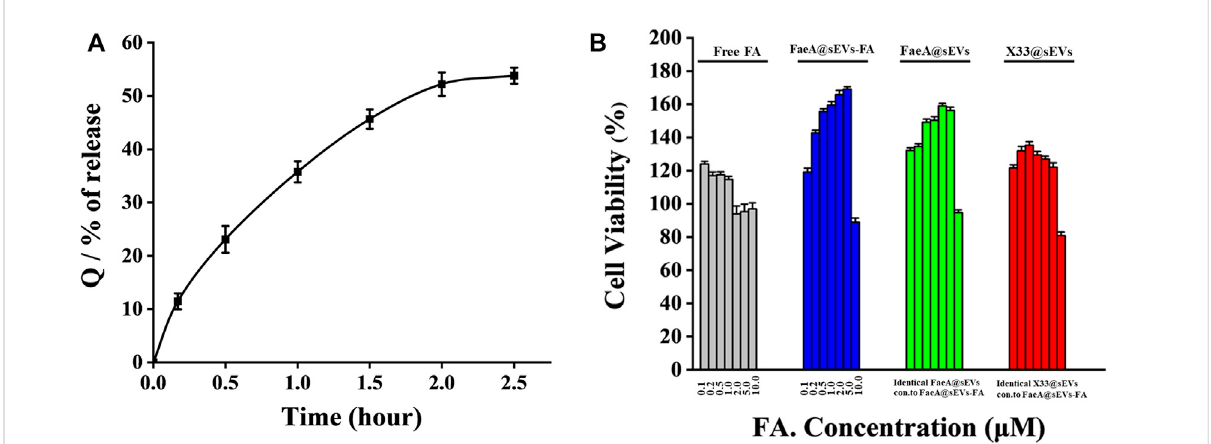
FIGURE 6 Transdermal administration in vitro drug release pattern and cytotoxicity of FaeA@sEVs-FA. (A) Cumulative release Q of active drug molecules from FaeA@sEVs-FA within 2.5 h (B) CCK-8 based viability measurement of HEK293T cells incubated with free FA, FaeA@sEVs-FA, FaeA@sEVs and X33@sEVs at various concentrations ranging from 0.1 to 10.0 μ M, respectively. Note: the particle concentration of X33@sEVs and FaeA@sEVs was identical to FaeA@sEVs-FA. ( n = 3, mean ± SD).